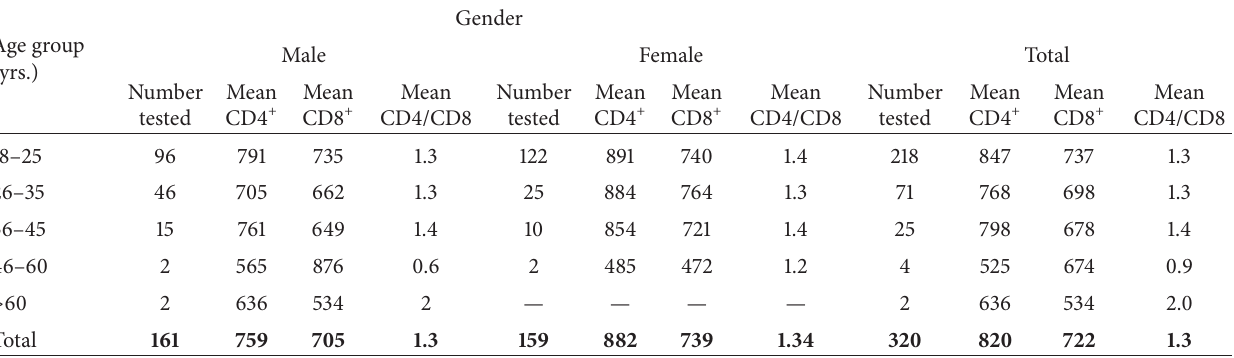
Table 3: The mean reference value of T lymphocytes subpopulation/ 𝜇 L blood in HIV negative adults who visited VCT, University of Gondar Hospital, Ethiopia by age and sex,